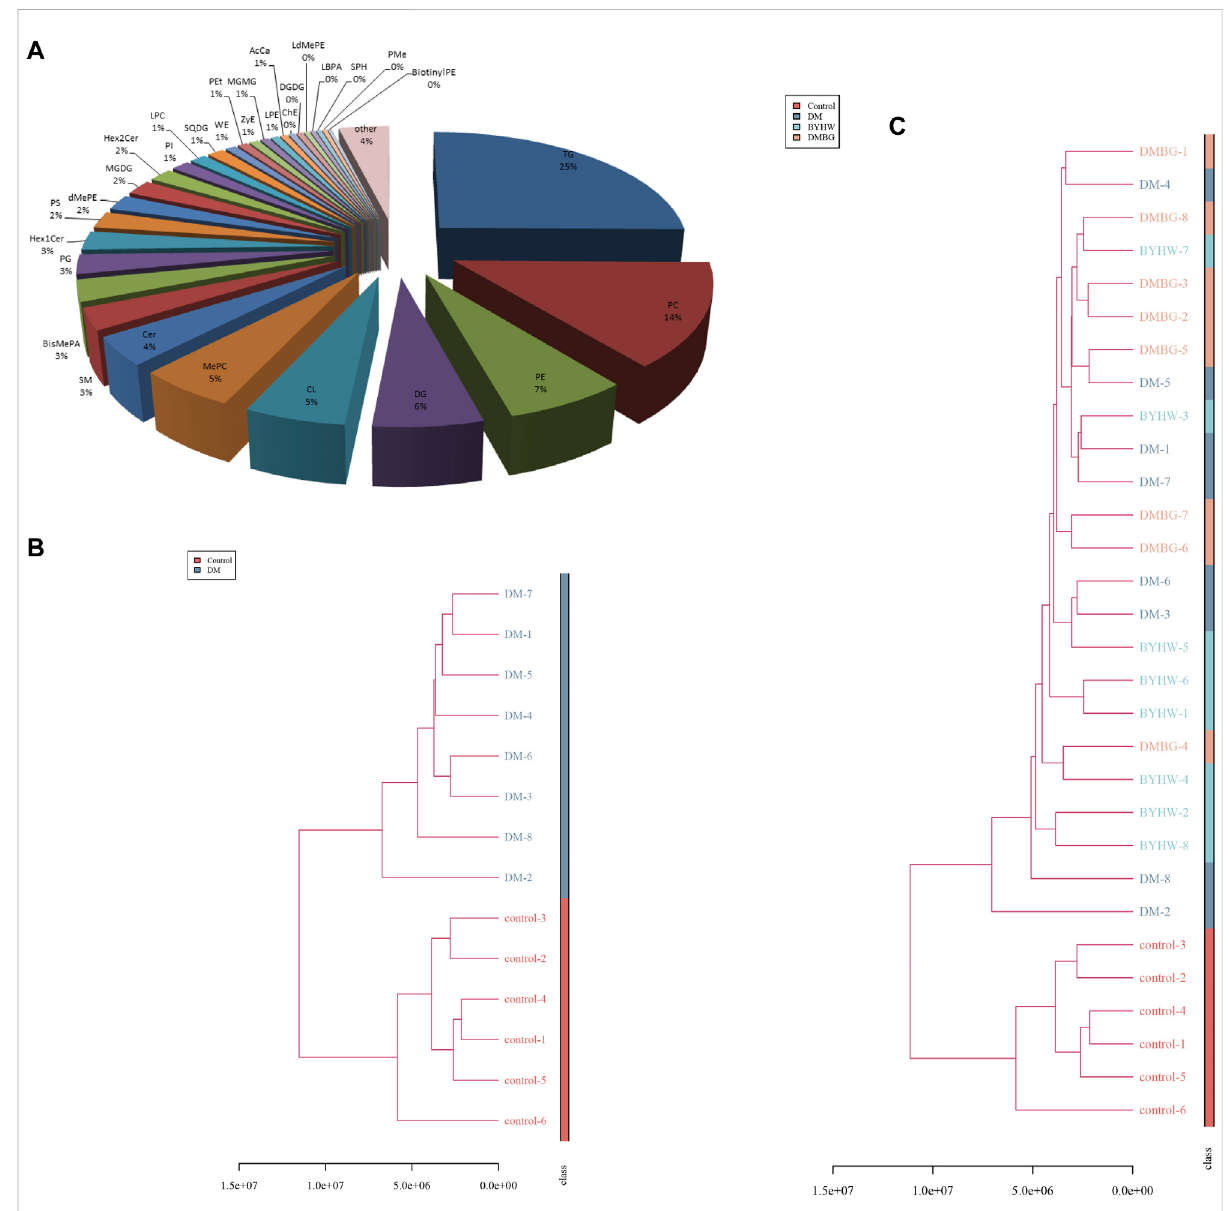
FIGURE 8 KEGGanalysisforBYHWDinvolvedindicativedifferentgut fl oraeinresponsetotherelativeabundanceofdifferentfunctionalcategories: (A) the histogramoftherelatedfunctionalcategoriesofthefourgroups; (B) theheatmapofrelatedfunctionalcategoriesofthefourgroups; (C) signi fi cantly different functional categories between the DM and BYHWD groups.